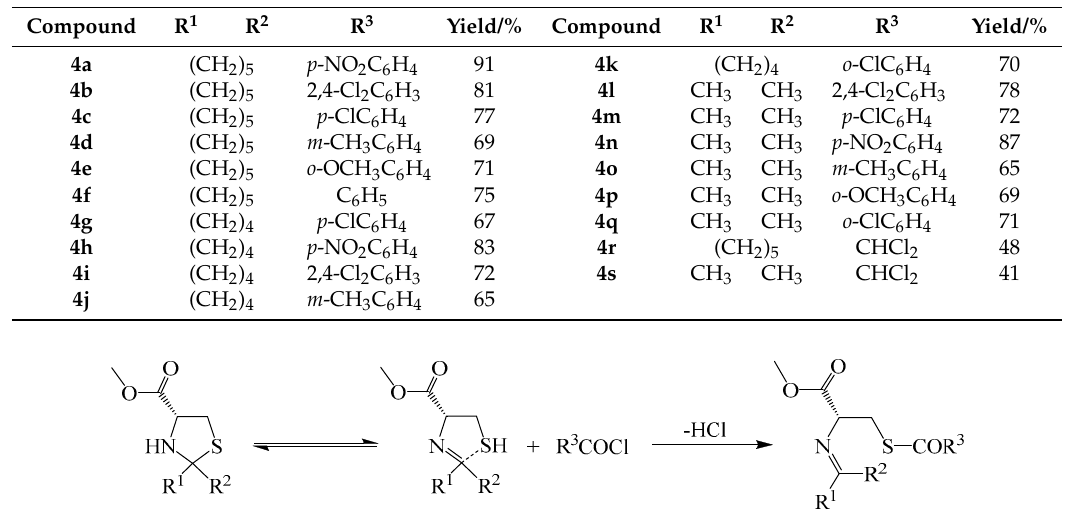
Table 1. Yields of title compounds.